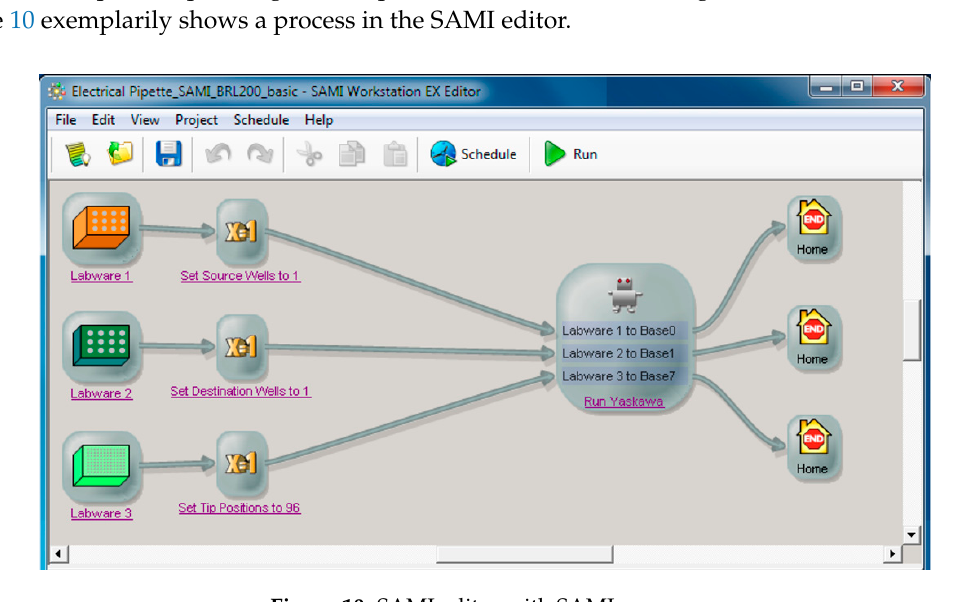
Figure 10. SAMI editor with SAMI process.